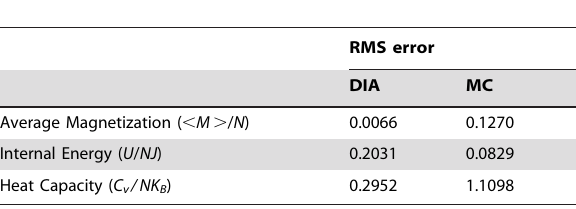
Table 2. Accuracy